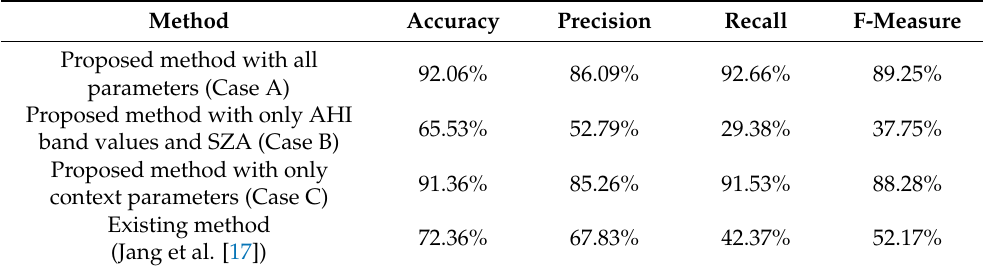
Table 4. Results of performance evaluation study for the proposed method (three cases) and the existing method (i.e., the method of Jang et al.